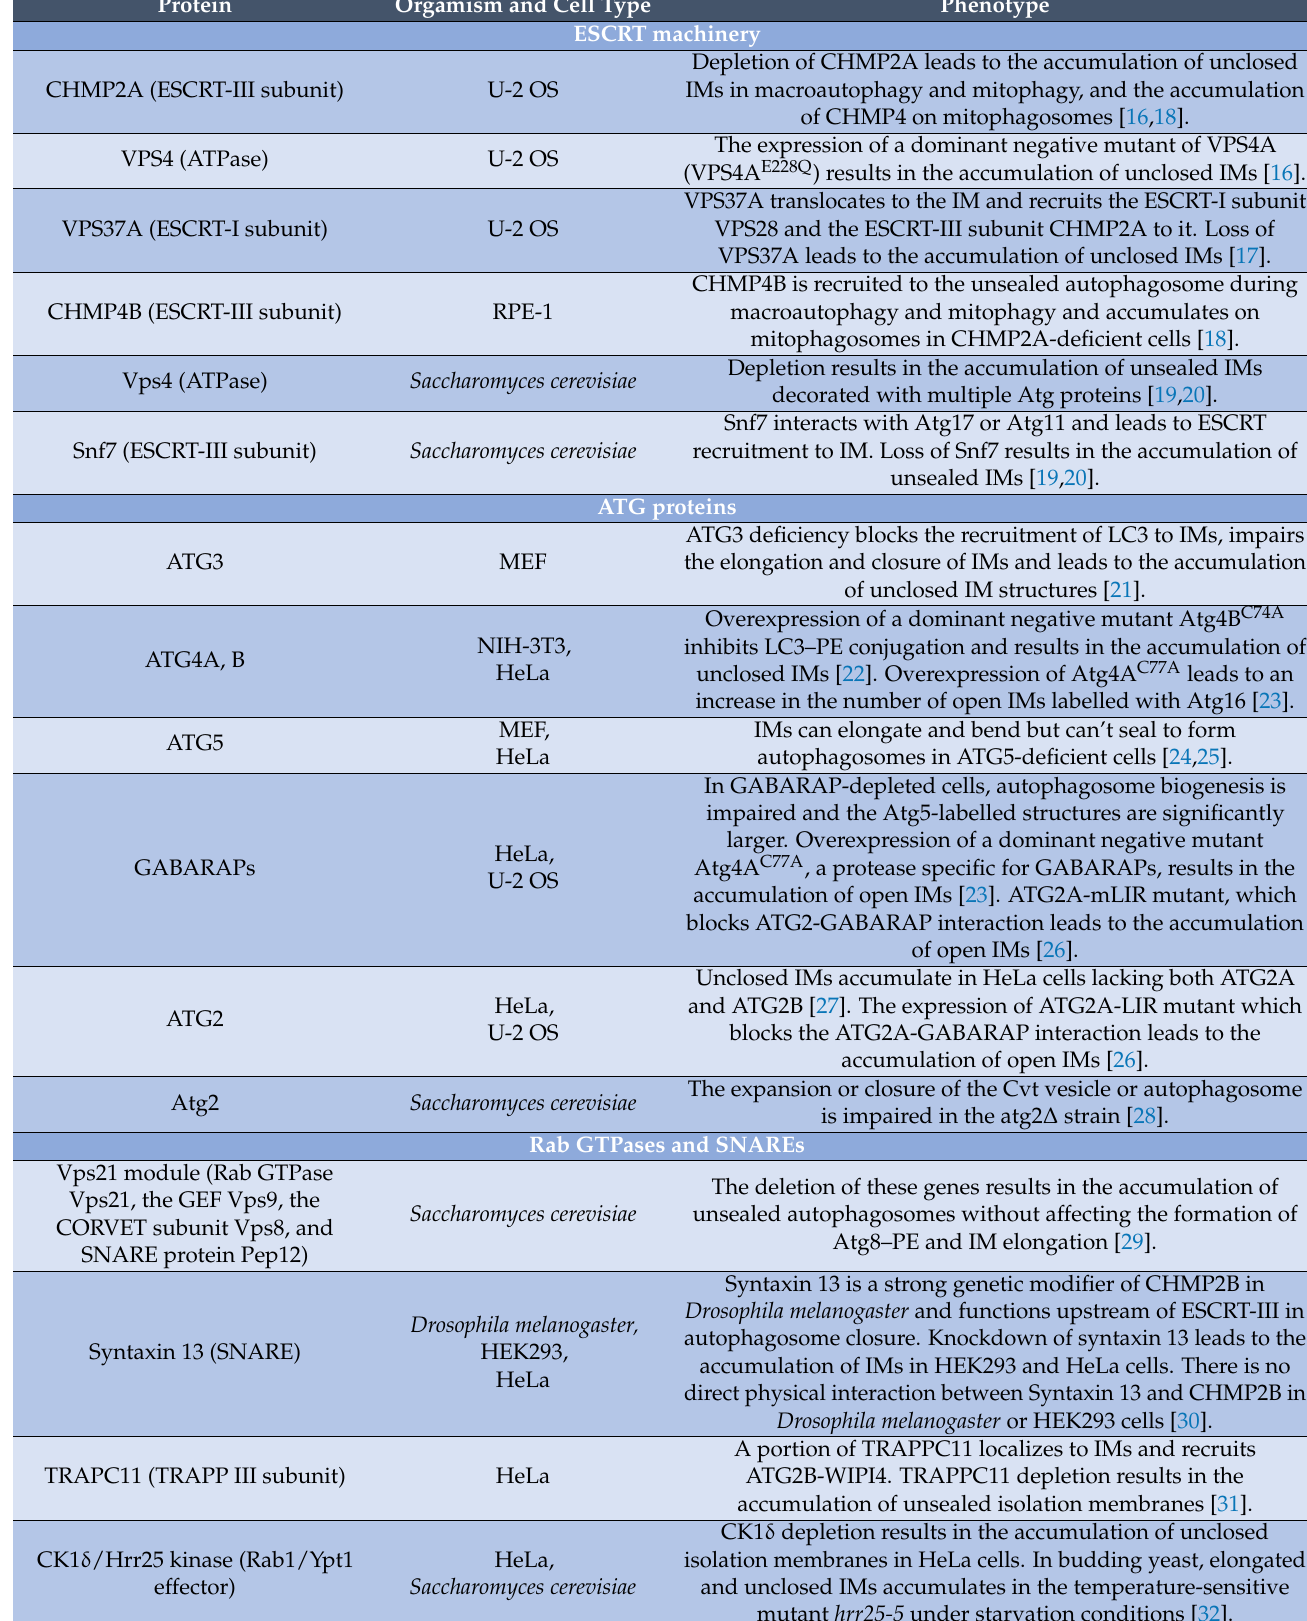
Table 1. Key regulators of autophagosome